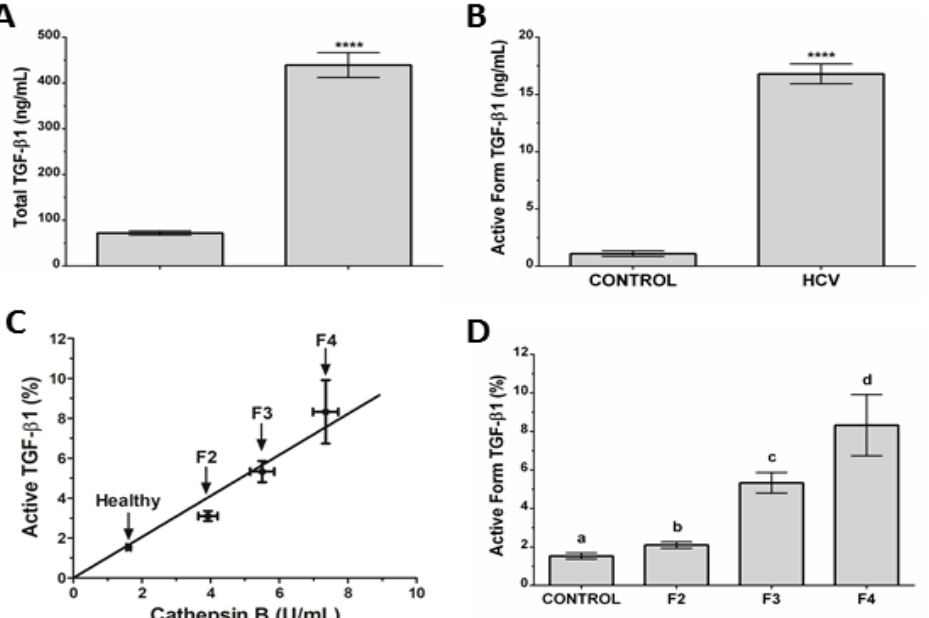
Figure 4. TGF- β 1 levels in the serums of CHC patients and HCs. ( A ) Total TGF- β 1 in HCV-infected patients and HCs. HCs (72.0 ± 4.4 ng/mL; N = 71), HCV (439 ± 27 ng/mL; N = 53). ( B ) Active form of TGF- β 1 in HCV-infected patients and HCs. HCs (1.10 ± 0.25 ng/mL; N = 71), HCV (16.8 ± 0.9 ng/mL; N = 53). ( C ) Association between Cat B and the active form of TGF- β 1 and hepatic fibrosis ( D ) Percentage of the active form of TGF- β 1 in HCV-infected patients and HCs. HCs (1.54 ± 0.16%; N = 71), HCV (F2 = 2.10 ± 0.17%; N = 17; F3 = 5.33 ± 0.53%; N = 23; F4 = 8.32 ± 1.59%; N = 13). Results are the mean ± SEM or percentage (%) of total concentration. Student’s t -tests were applied to identify differences between groups and repeated-measures ANOVA with Tukey’s post -hoc test. **** p < 0.0001; a ≠ b ≠ c ≠ d .